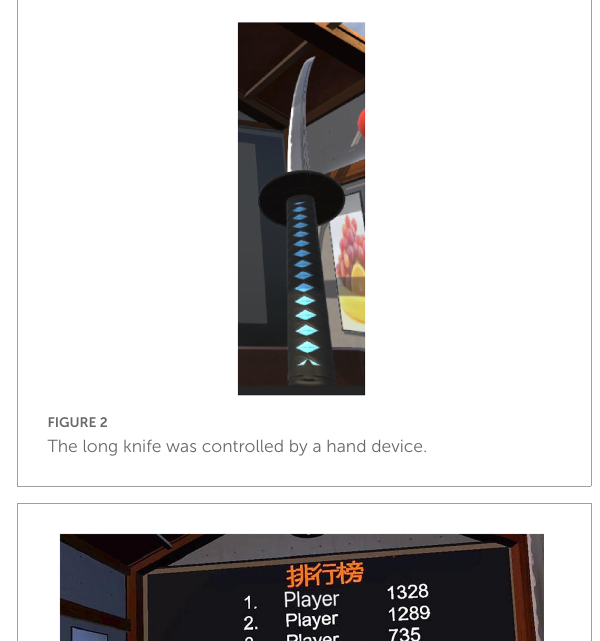
FIGURE3 The scoreboard displayed the participant’s score and